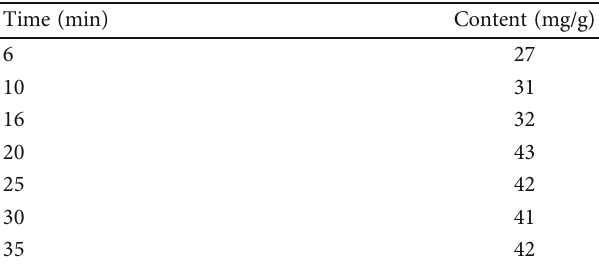
Table 5: In fl uence of brewing time on brewing conditions. Time (min) Content